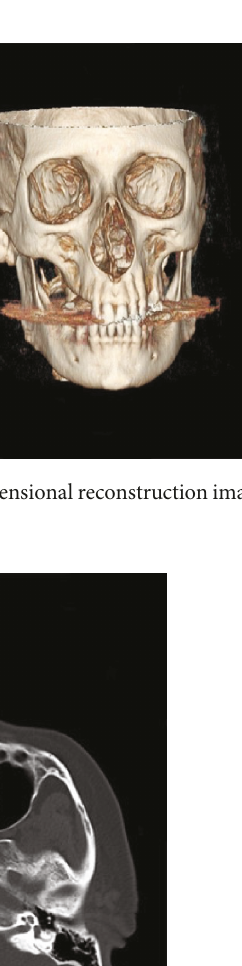
Figure 1: Clinical preoperative view showing preauricolar swelling on the right side of the face.